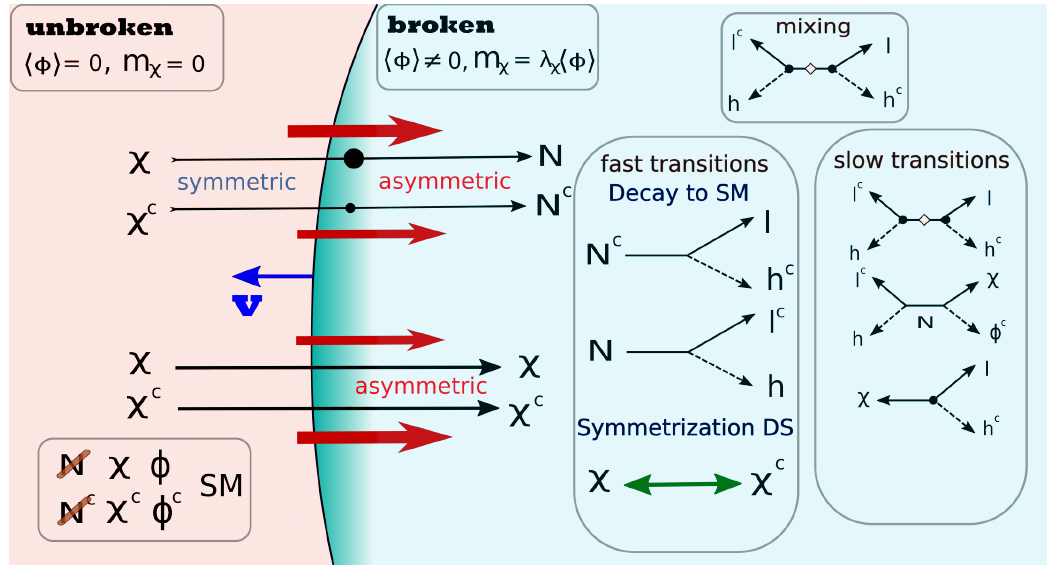
Figure 2 . Mechanism at play in the phase transition-induced leptogenesis. In the diagrams the black dot denotes a mixing between χ and N and so the insertion of a factor of θ , the white diamond is a χ mixing insertion. A thicker arrow designates a larger flux (though it is exaggerated on the